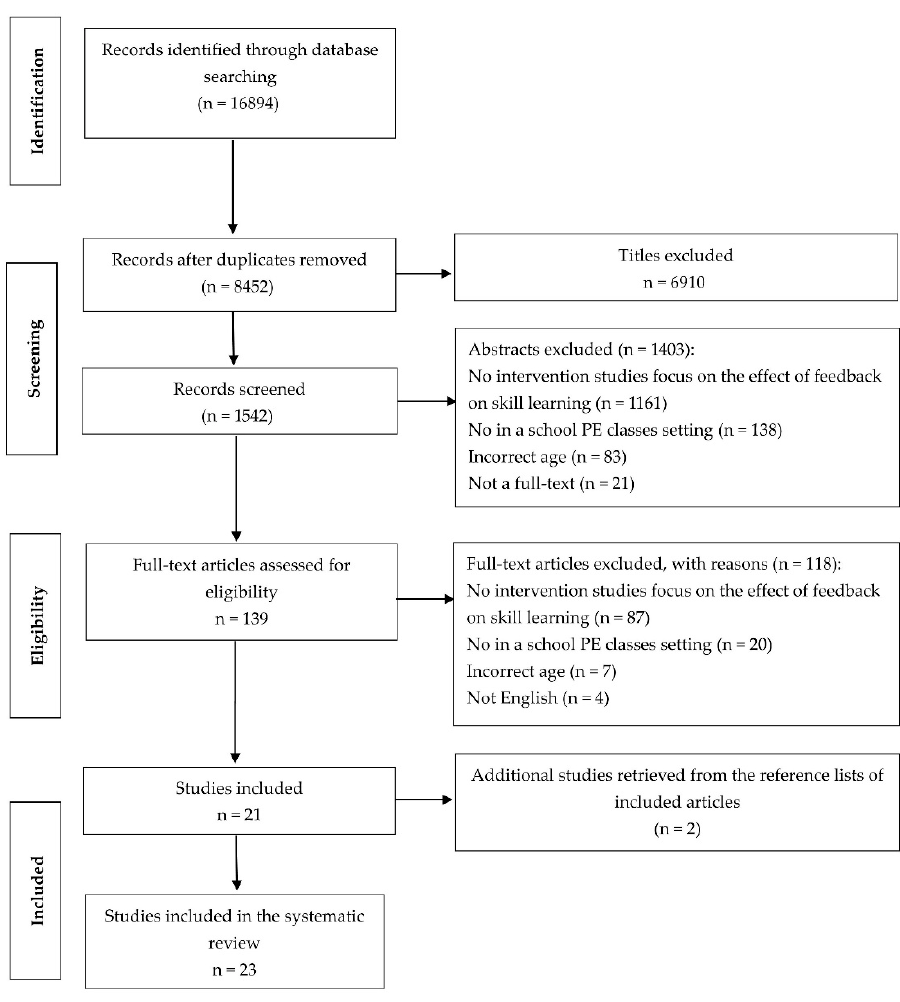
Figure 1. Flow diagram of the study selection process.